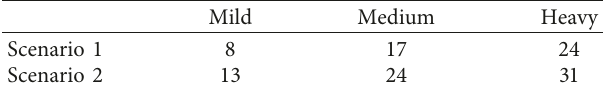
Table 2: Number of flows used in the simulation for each level of